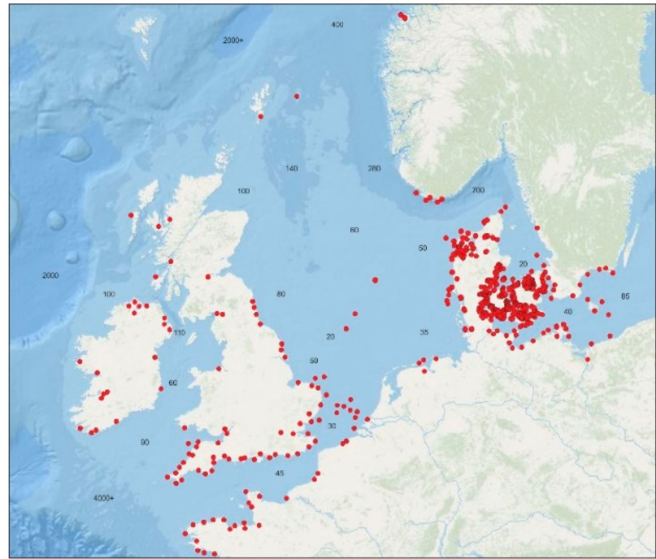
Figure 1. Recorded submerged Stone Age sites in northwest Europe. Depths given in meters. After Bailey et al. [36]. Graphic: